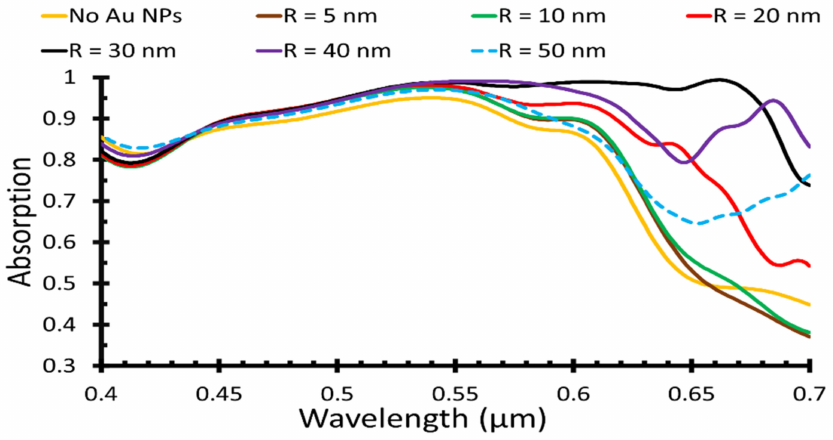
Figure 3. The light absorption of different AuNP radii with the